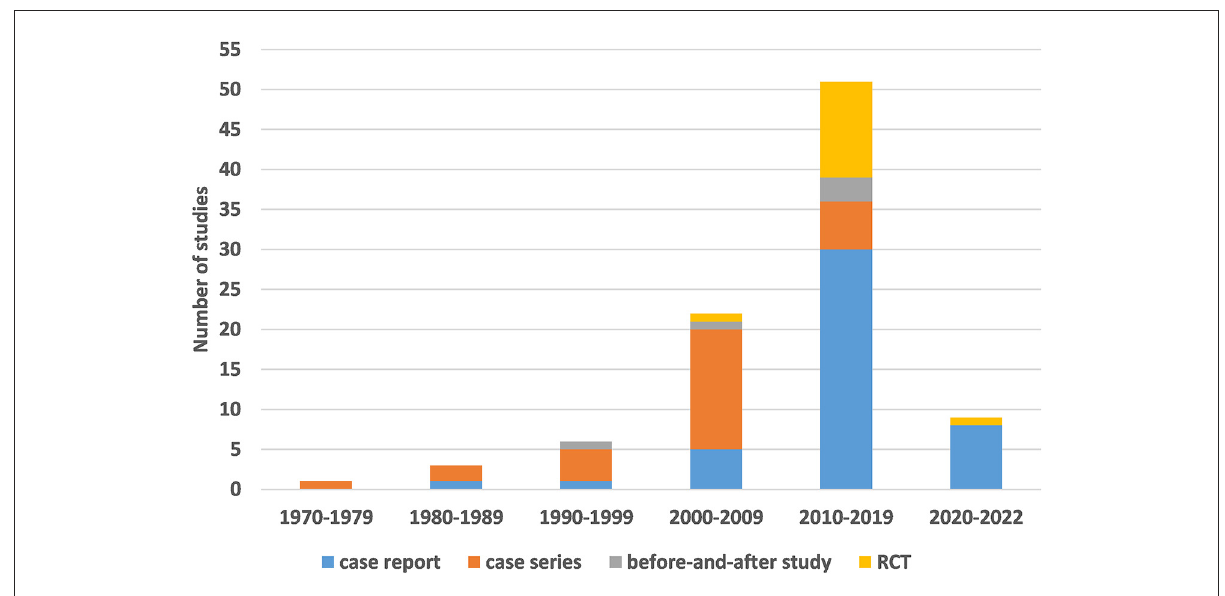
FIGURE2 The number of different study designs used, by year of